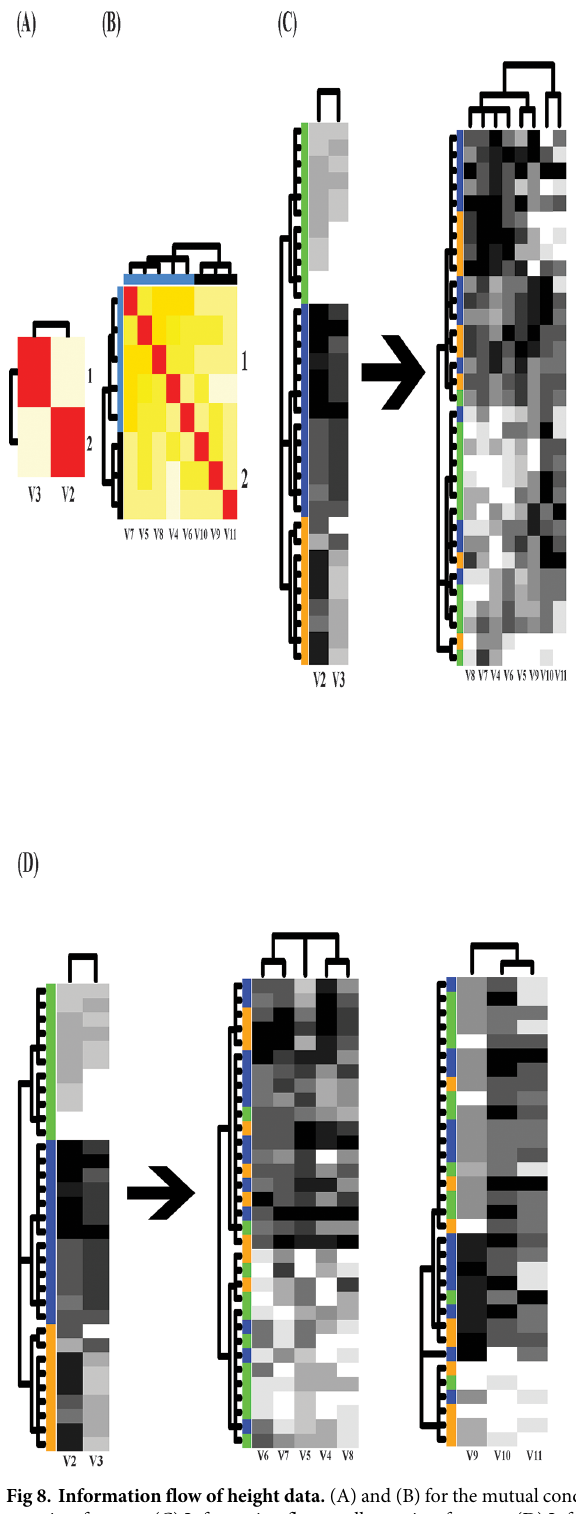
Fig 8. Information flow of height data. (A) and (B) for the mutual conditional-entropy matrices for response and covariate features; (C) Information flow to all covariate features; (D) Information flow to #1 feature-group and then #2